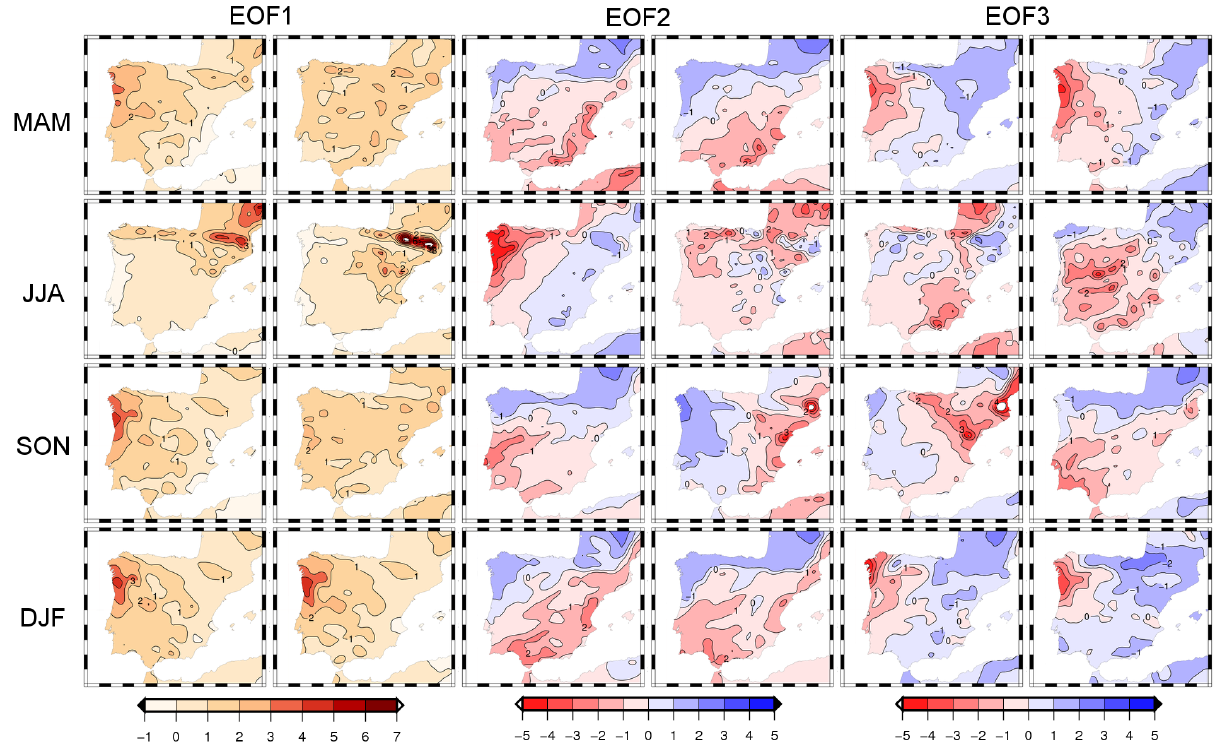
Fig. 9. Normalised EOF patterns obtained from the seasonal mean series of precipitation for the period 1961–1990 in the simulations ECHO-G+MM5 (left) and ERA40+MM5 (right). Table 2. Percentage of variance explained by each EOF of the seasonal mean series of precipitation.